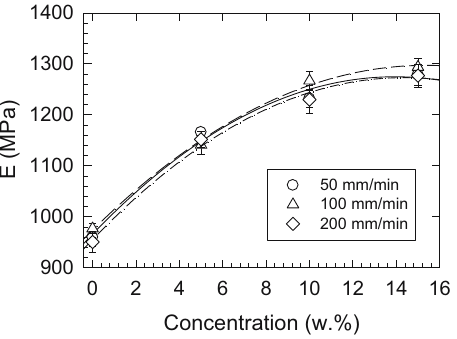
Figure 4: Fracture toughness and maximum force vs perlite fi ller